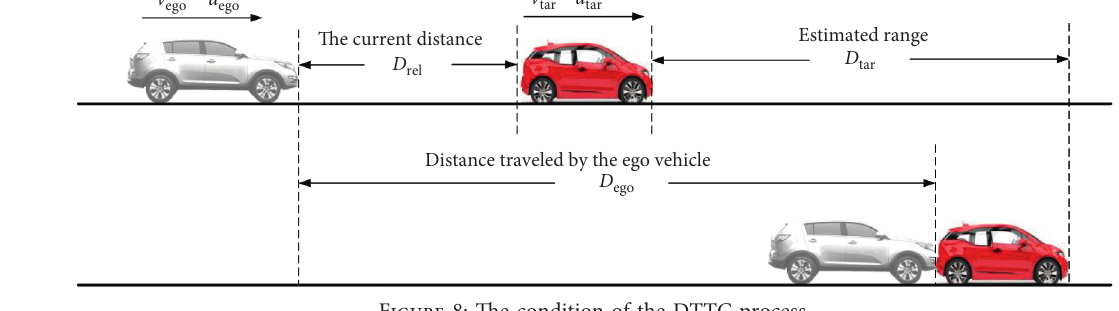
Figure 8: The condition of the DTTC